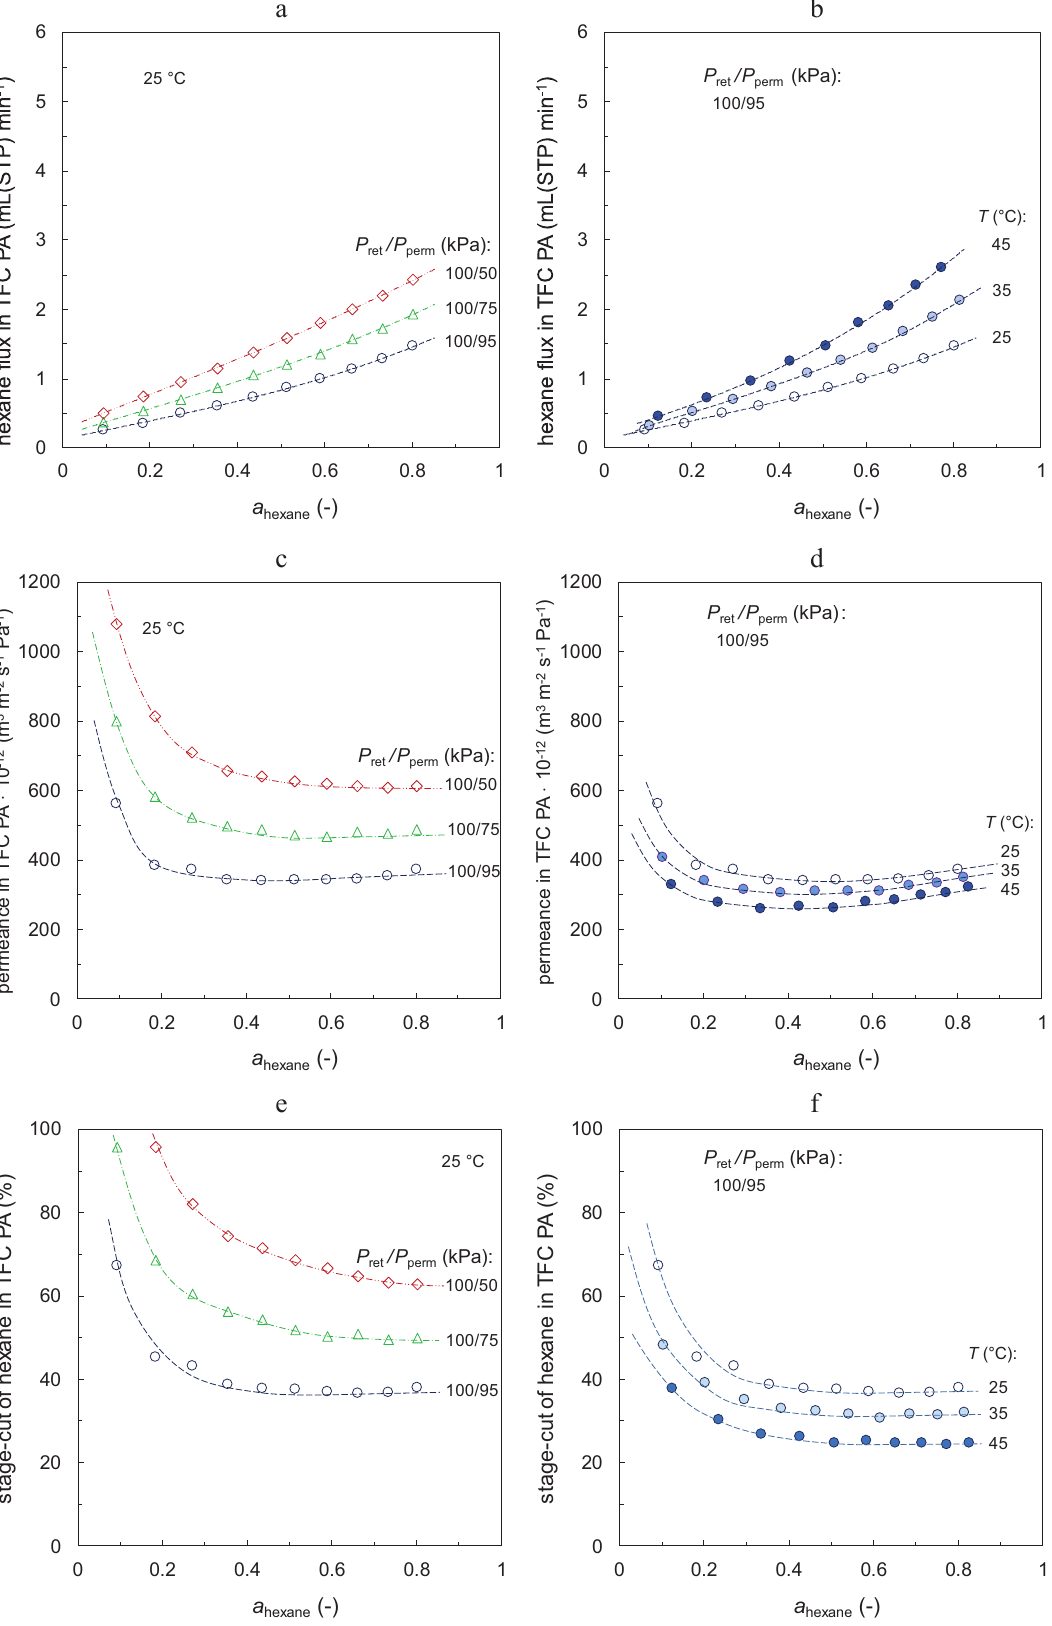
Fig. 4 – Results of permeation experiments with TFC PA (Toray) membrane: a, b) Hexane flux as a function of the hexane activity, temperature and trans-membrane pressure; c, d) Hexane permeance as a function of the hexane activity, temperature and trans-mem - brane pressure; e, f) Hexane stage-cut as a function of the hexane activity, temperature and trans-membrane pressure; The lines are intended as a guide to the eye.